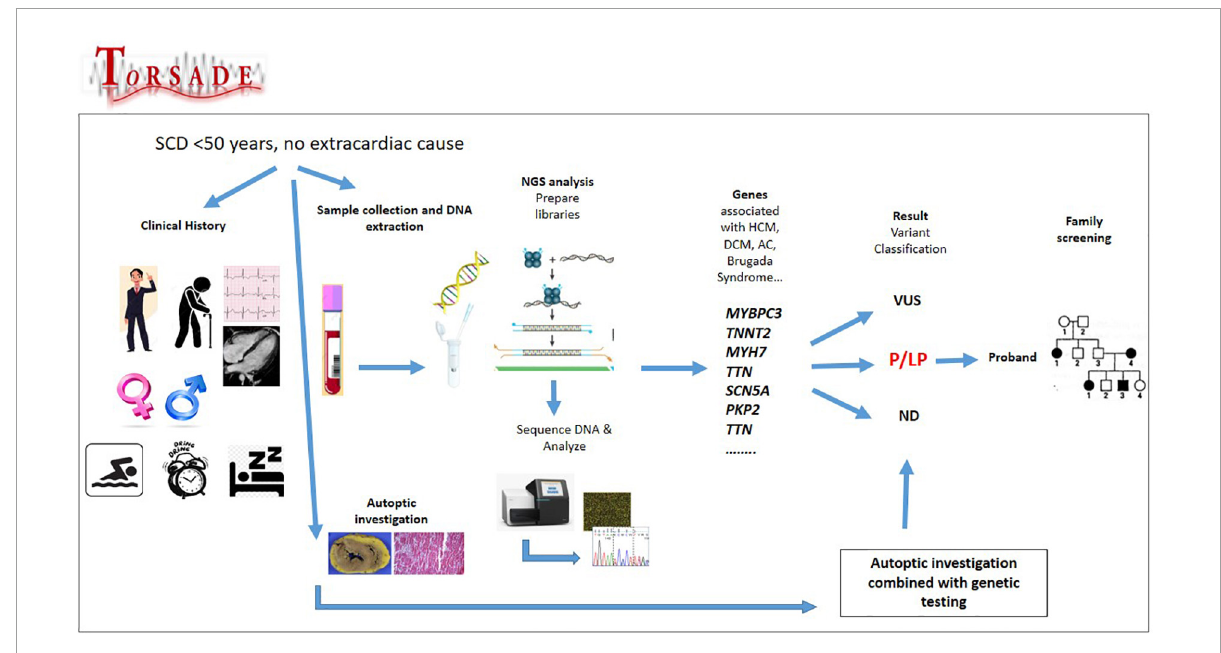
FIGURE1 Genetic characterization of ToRSADE patients: an overview of ToRSADE workflow for the genetic characterization of diseases involved in sudden cardiac